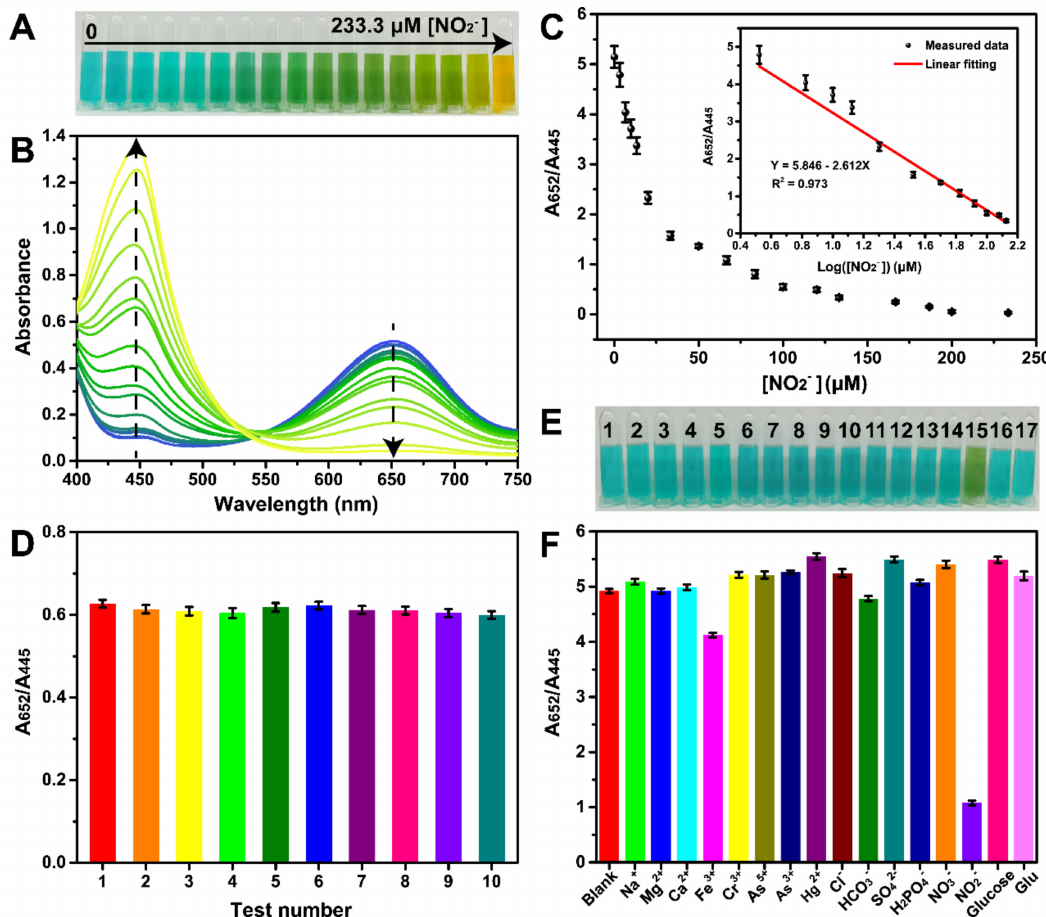
Figure 4. ( A ) is the photograph of the hollow MnFeO+TMB system with the presence of increasing nitrite (the concentration of nitrite increases from 0 to 233.3 µ M). ( B ) displays UV-vis spectra of the hollow MnFeO+TMB+NO 2 − system with nitrite at different levels. ( C ) presents the relationship of the response of nitrite and its concentration (the inset shows the corresponding linear relationship). ( D ) displays the response of the hollow MnFeO+TMB+NO 2 − system in repetitive tests (the concentration of NO 2 − is 100 µ M). ( E ) is the photograph of the responses of various species toward the hollow MnFeO+TMB system (1—Blank, 2—Na + , 3—Mg 2+ , 4—Ca 2+ , 5—Fe 3+ , 6—Cr 3+ , 7—As 5+ , 8—As 3+ , 9—Hg 2+ , 10—Cl − , 11—HCO 3 2 − , 12—SO 4 2 − , 13—H 2 PO 4 − , 14—NO 3 − , 15—NO 2 − , 16—Glucose and 17—Glu), and ( F ) displays UV-vis spectra of the responses of various species toward the hollow MnFeO+TMB system (the concentration of NO 2 − is 50 µ M, and the concentrations of other species are 100 µ